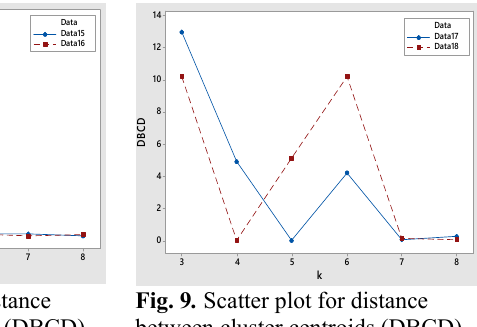
Fig. 8. Scatter plot for distance between cluster centroids (DBCD) vs k for Data15-Data16